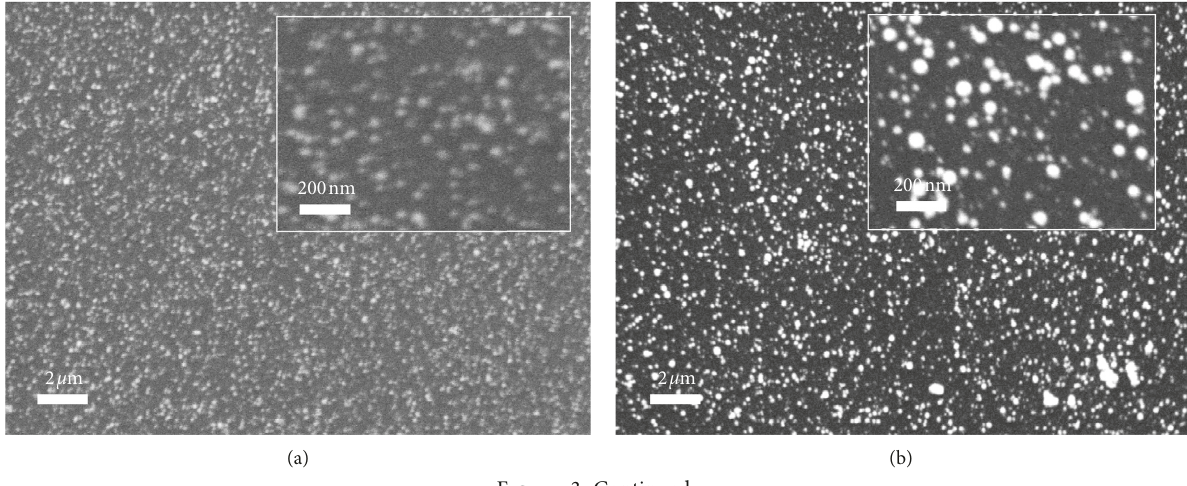
Figure 2: SEM image of the Si surface covered with gold deposited from a solution of 4mM H[AuCl at 40 ° C (a), 50 ° C (b), and 60 ° C (c), and the size distribution histograms of AuNPs